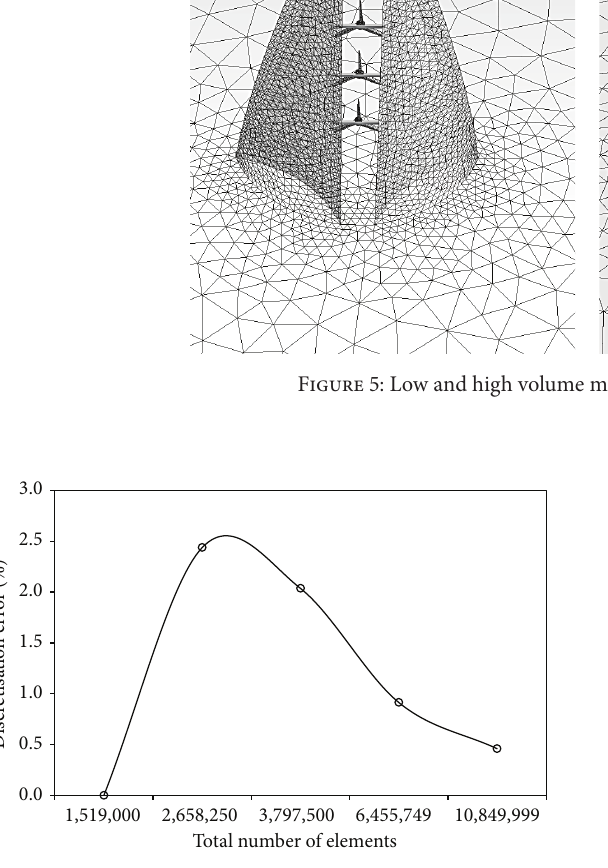
Figure 6: Variation in discretisation error at increasing number of